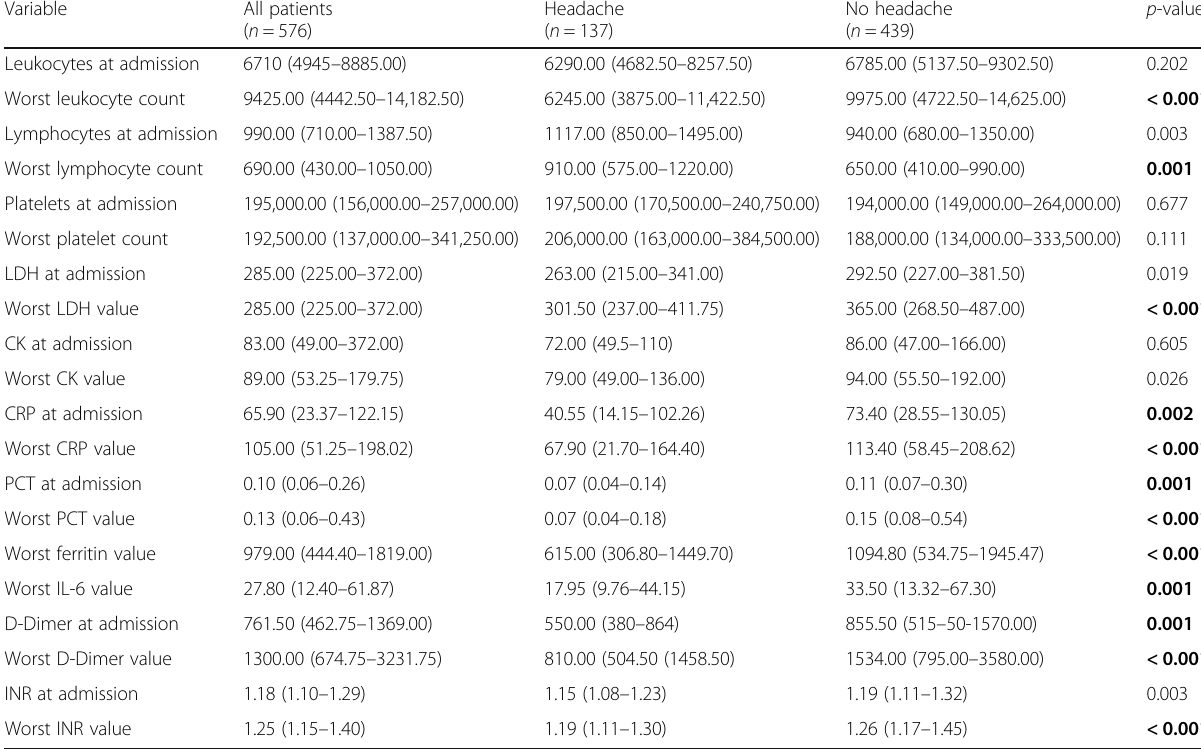
Table 4 Median values of laboratory parameters in the whole sample and the comparison between patients with and